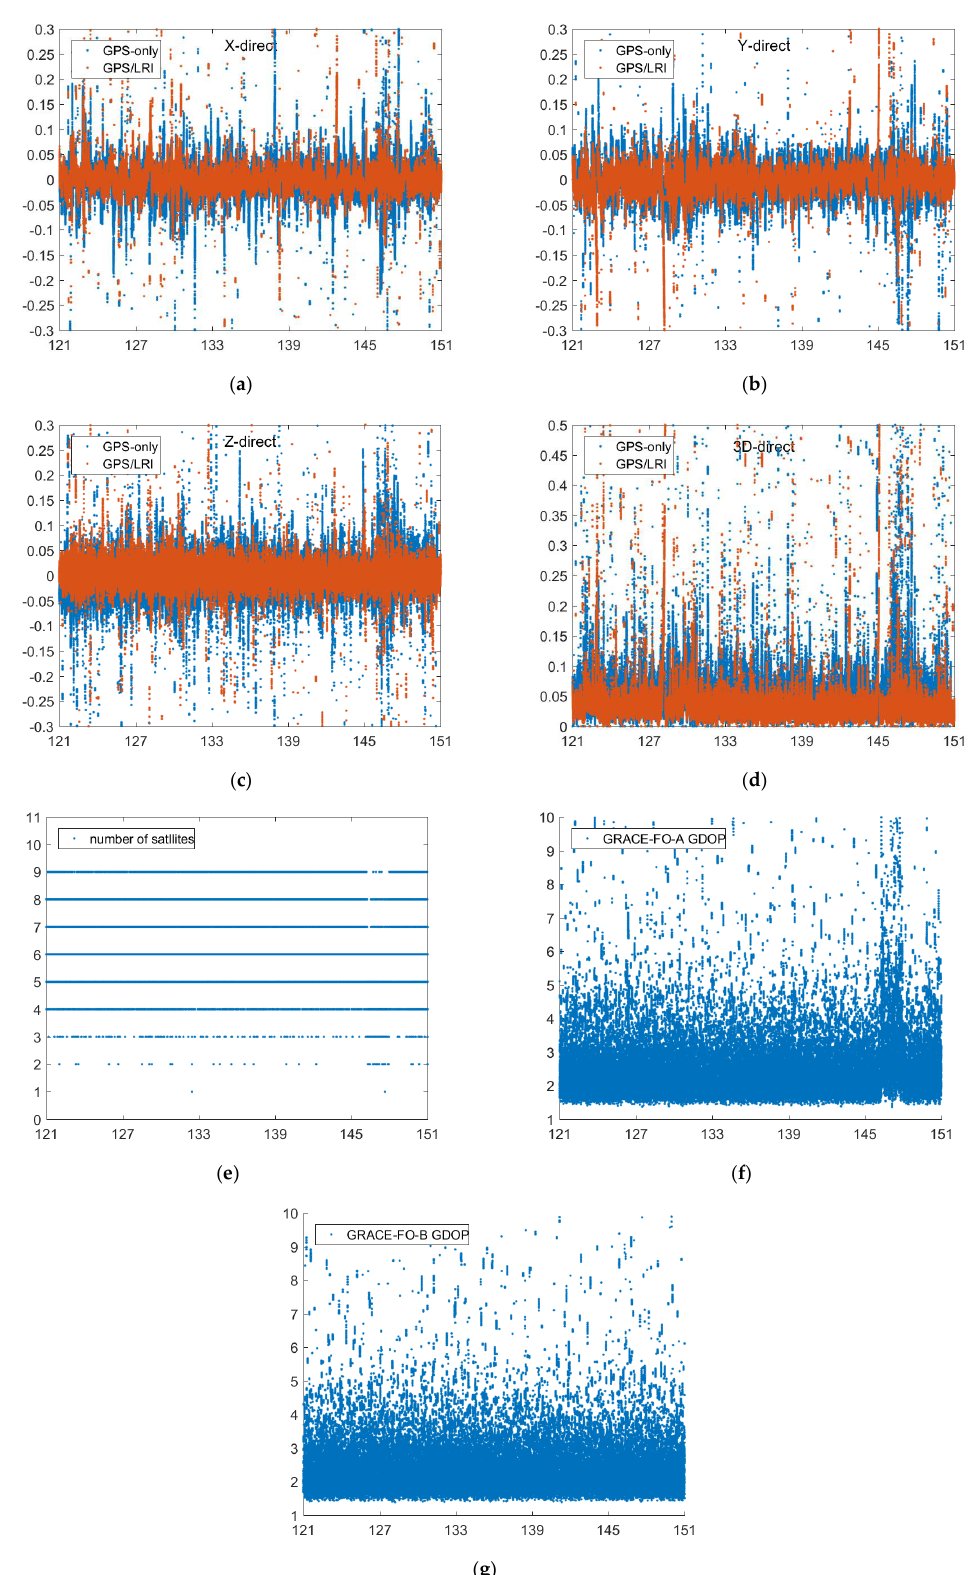
Figure 2. Reference orbit check for GRACE-FO in the X, Y, Z, 3D (X, Y, Z are components of the baseline vector, unit: m , ( a – d )) directions (days 121–151), number of satellites for each epoch( e ) and GDOP( f , g ).